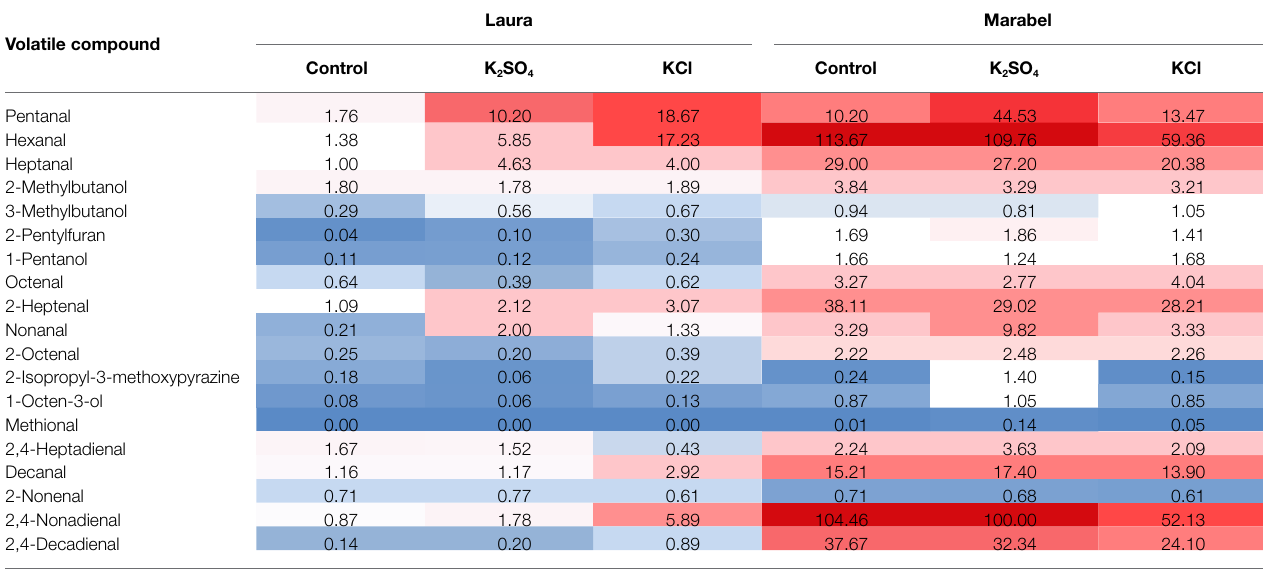
TABLE 2 | Fold changes of volatile compounds comparing raw and boiled potato tubers at harvest in 2020 depending on fertilisation and cultivar. Laura Marabel Volatile compound Control